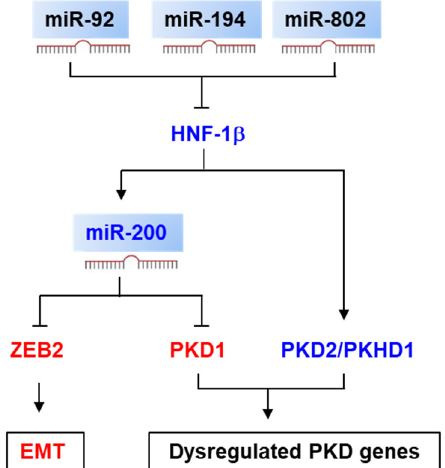
Figure 3. Signaling pathways modulated by miRNAs in HNF1 β -associated kidney diseases. miR-92, miR-194 and miR-802 decrease the expression of HNF1 β through directly binding with the 3 ′ -UTR of HNF1b, and HNF1 β positively regulates the expression of miR-200. Deletion of HNF1 β results in the upregulation of ZEB2, a target of miR-200, which promotes the EMT. Deletion of HNF1 β also increases the expression of PKD1 via miR-200. In addition, HNF1 β directly regulates the transcription of PKD2 and PKHD1. Arrow indicates a positive effect. “T” indicates a negative effect.